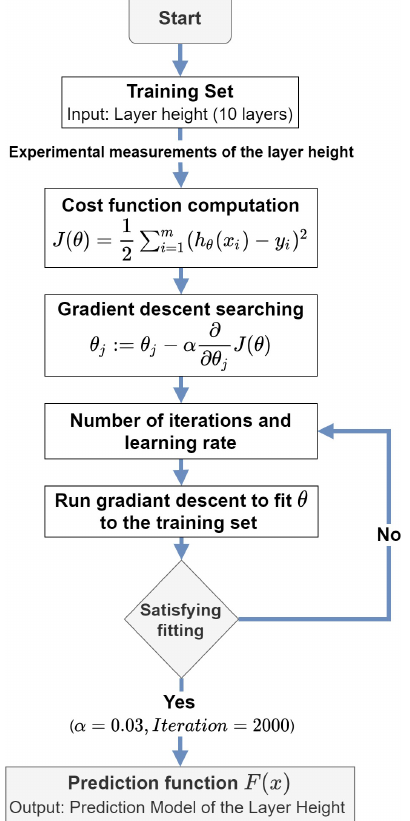
Figure 5. Flowchart of the bead height prediction